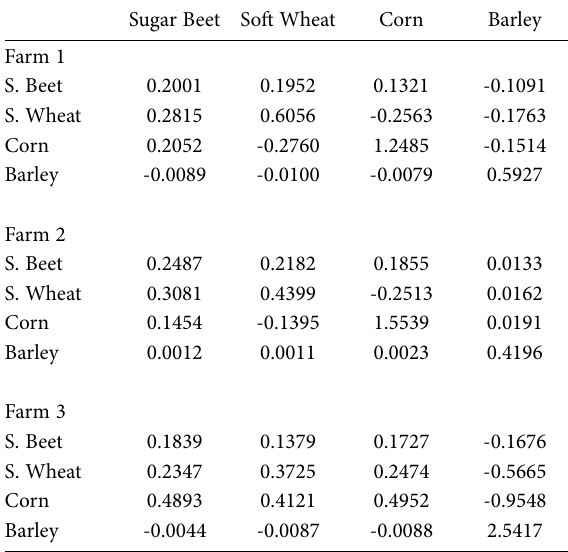
Table 5. Endogenous own- and cross-supply elasticities for three farms.